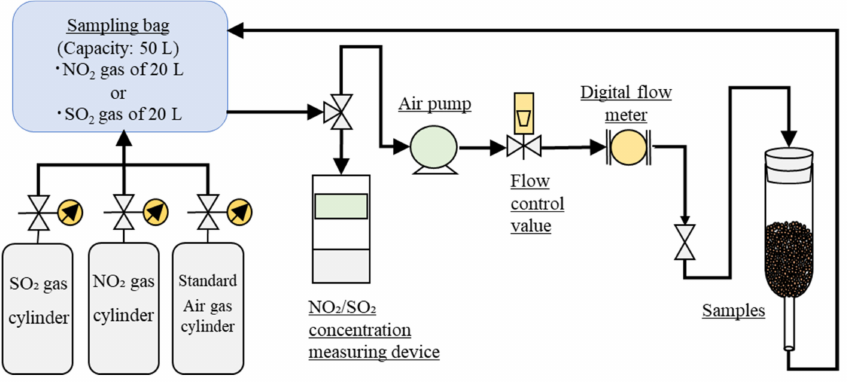
Figure 4. Schematic diagram of the NO 2 and SO 2 adsorption